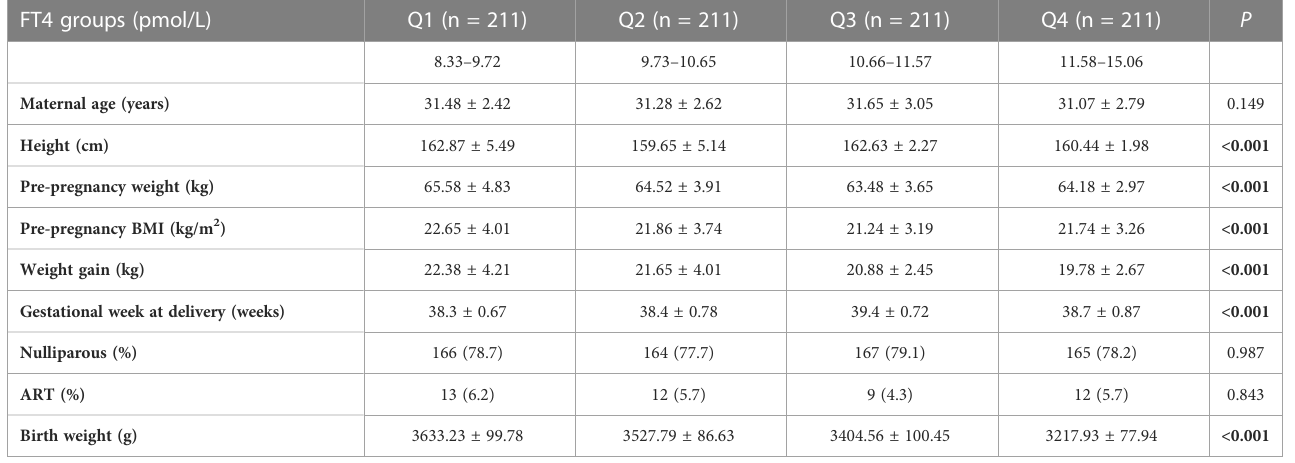
TABLE 1 Clinical characteristics of pregnancy by FT4